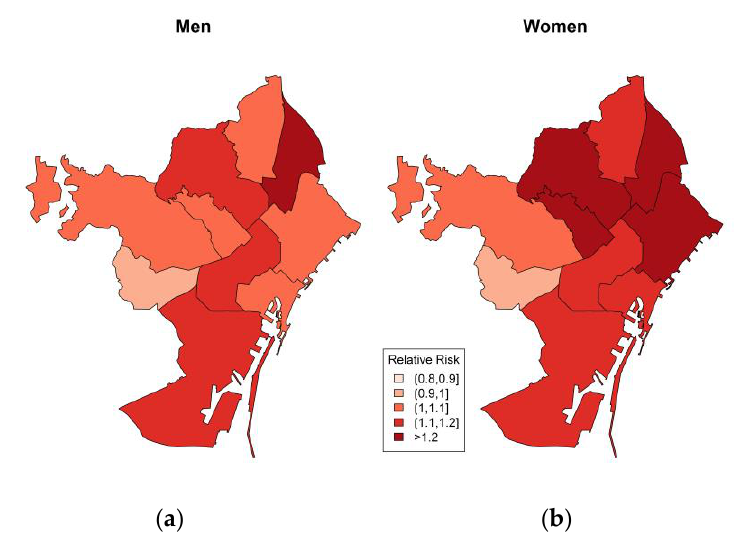
Figure 3. Relative risk of all-cause mortality related to summer extreme temperatures by district during the study period 1992–2015 in Barcelona in ( a ) men and ( b ) women.